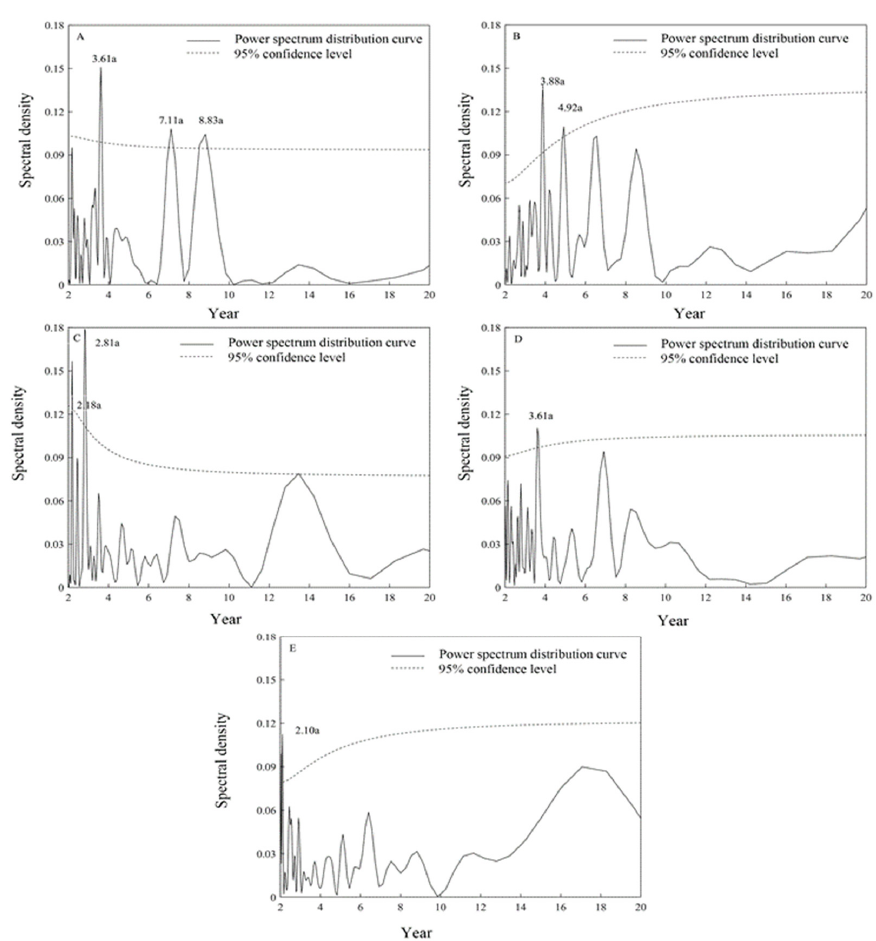
Figure 5. Regime shift index of humidity index in five provinces of Northwest China from 1960 to 2020. Note: ( A ) annual cycle ( B ) spring cycle ( C ) summer cycle ( D ) autumn cycle ( E ) winter cycle.